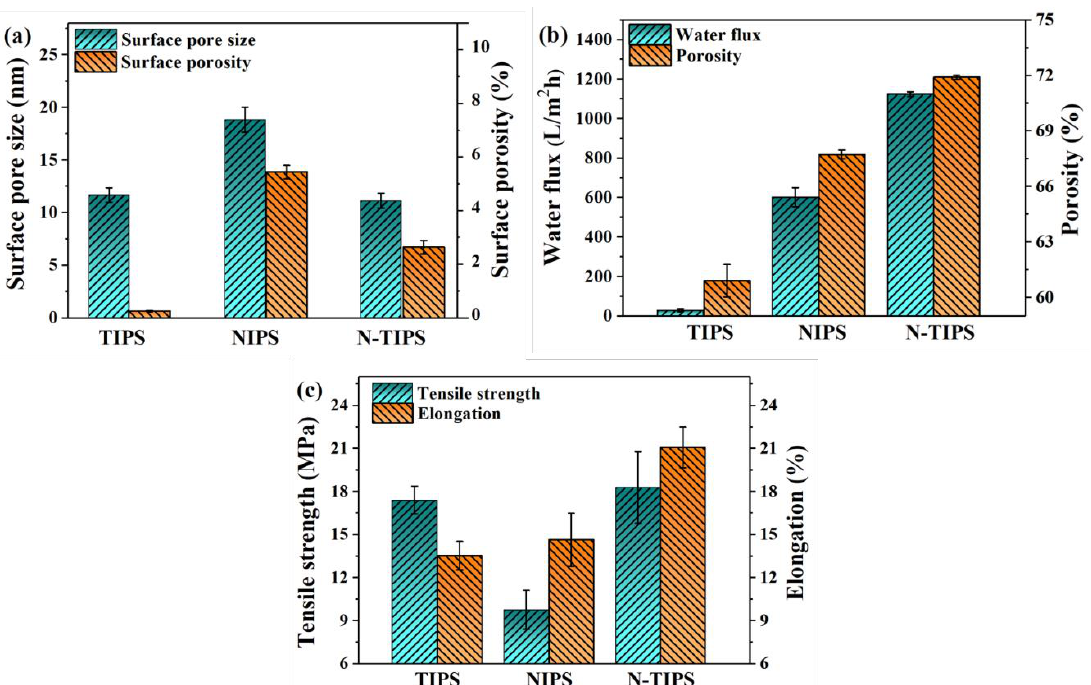
Figure 3. ( a ) Surface pore size and surface porosity of CTA porous substrates; ( b ) water flux and